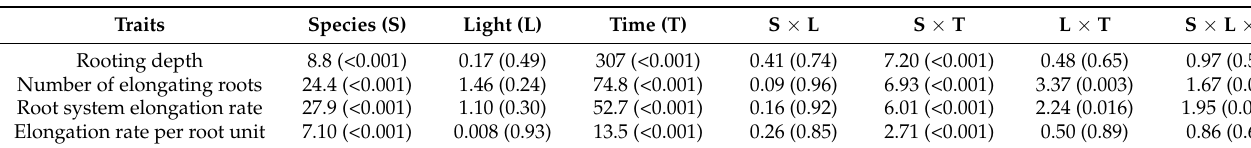
Table 1. Statistical results of the effect of species and light level on root dynamic traits in rhizotrons. Data are F -values and p -values in brackets.